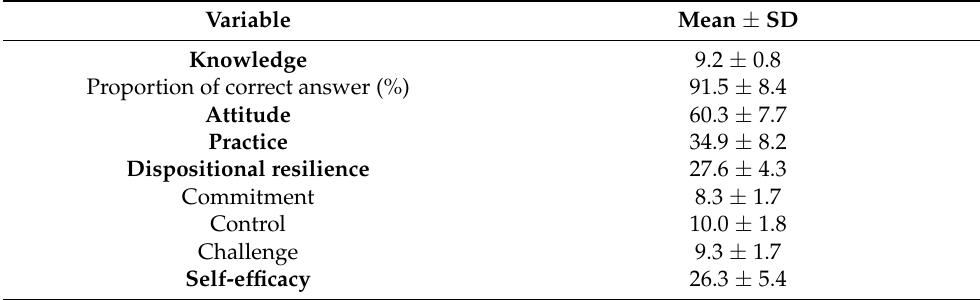
Table 2. Knowledge, attitude, and practice toward ACP of terminally ill patients, dispositional resilience, and self-efficacy among nurses (N = 266).